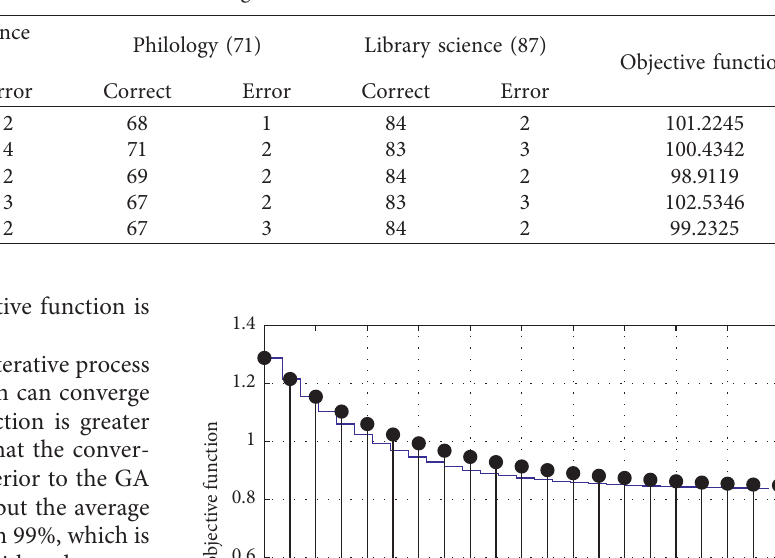
Table 5: FCM clustering results.